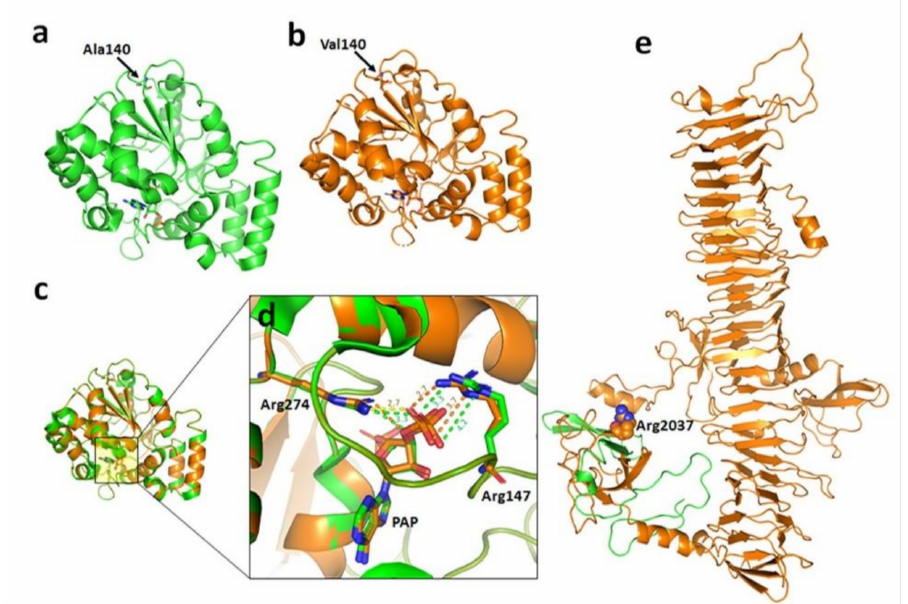
Figure 3. ( a ) Homology model of wild and ( b ) mutant type of SULT2B1 protein. Residues at position 140 are shown in stick model. ( c ) The superimposed structure of wild (green color) and mutant (yellow color) SULT2B1. ( d ) The zoom-up view of PAP binding site in wild type and mutant display difference sin distance which suggest the p. Ala140Val may contribute to the cofactor binding. ( e ) Homology model of FLG from residues 1960–2854. The residue Arg2037 is shown with sphere representation. The orange color ribbon is absent in the p. Arg2037Ter (mutant